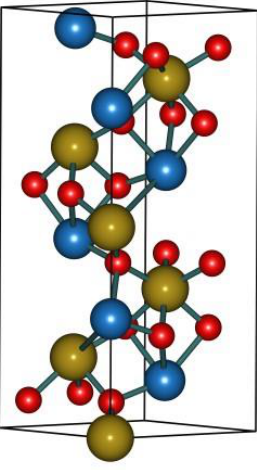
Figure 5. Structure of perovskite type ZnSnO 3 bulk. Red, blue and yellow are O, Zn and Sn atoms respectively.